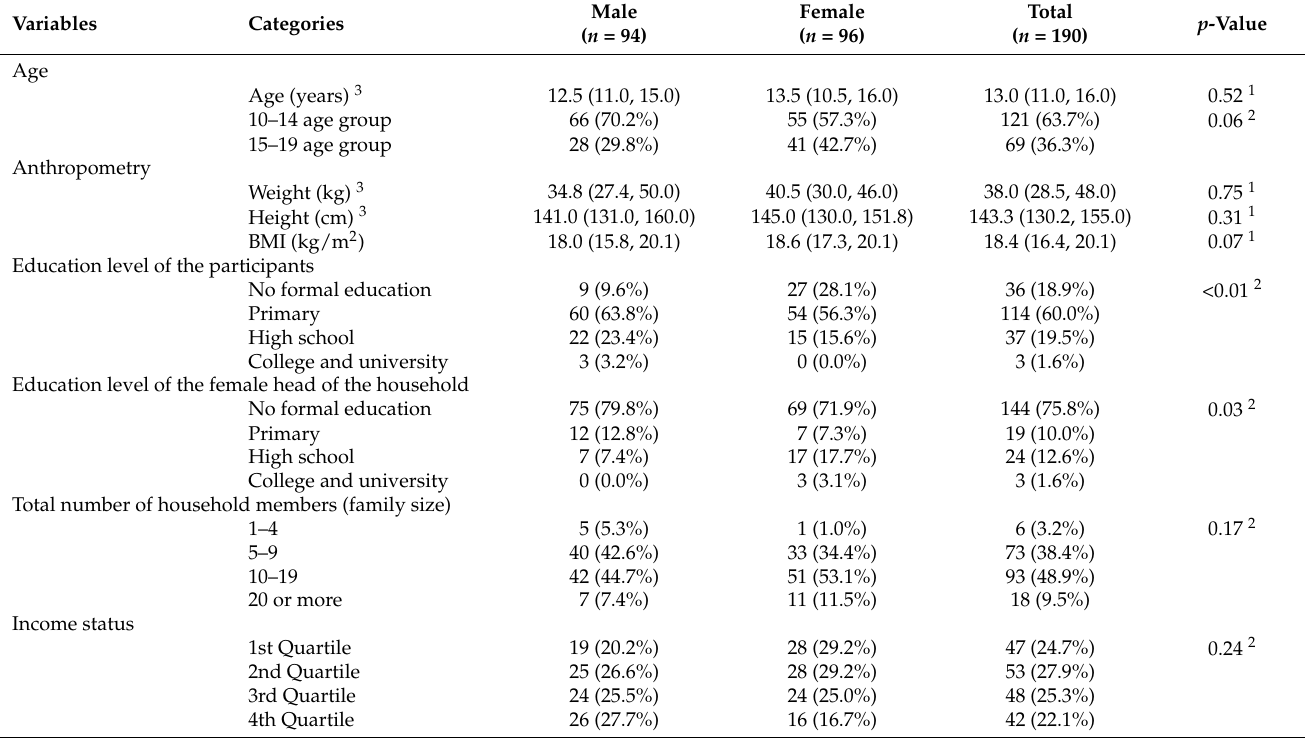
Table 1. Background characteristics of the study participants *.